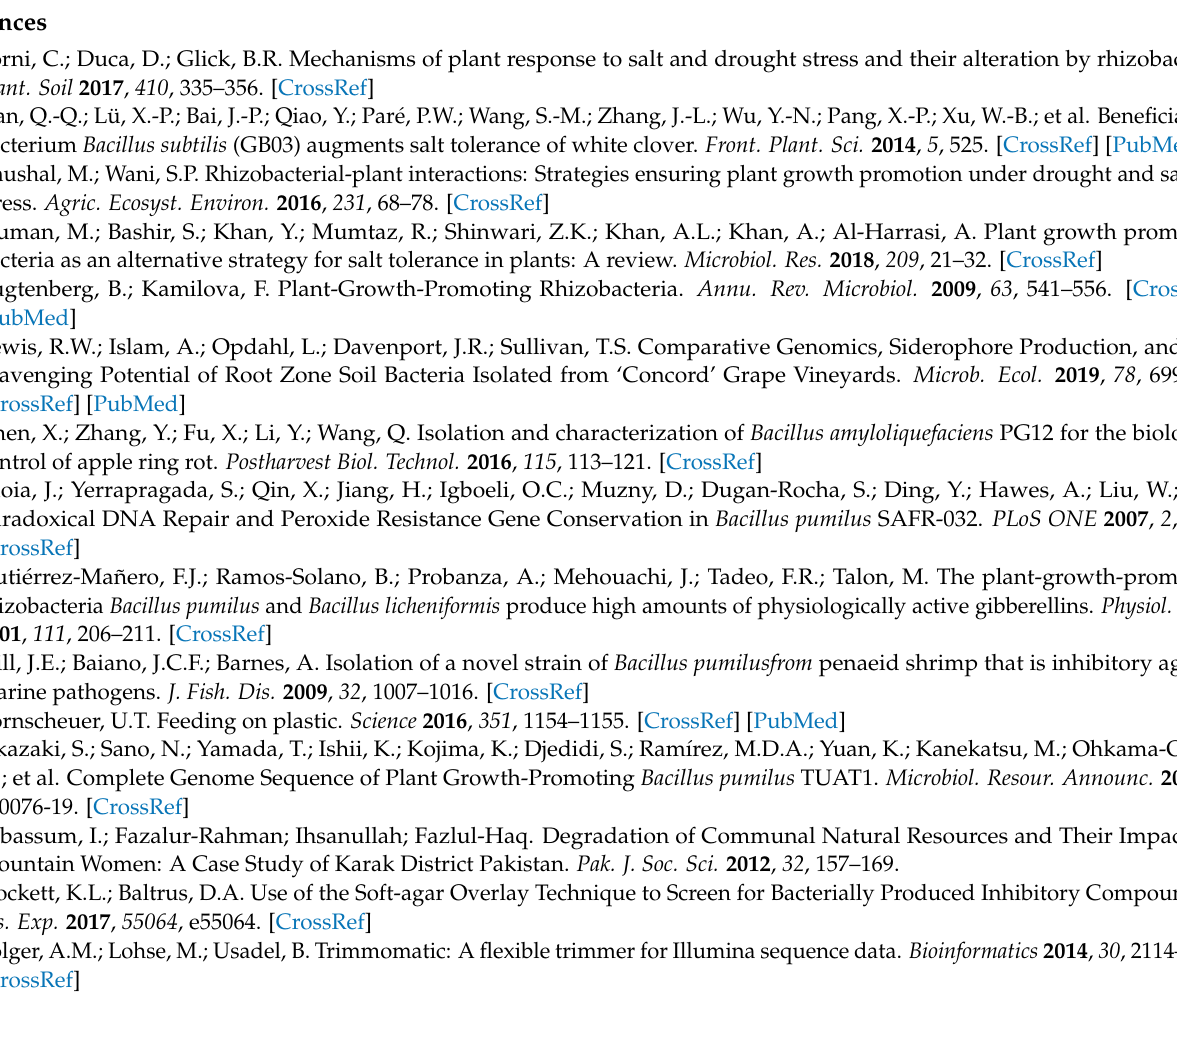
pumilus strain SF-4, Table S4: Characterization of BGCs identified in B. pumilus SF-4 genome, Table S5: Table S6: Plant growth promoting capabilities of B.